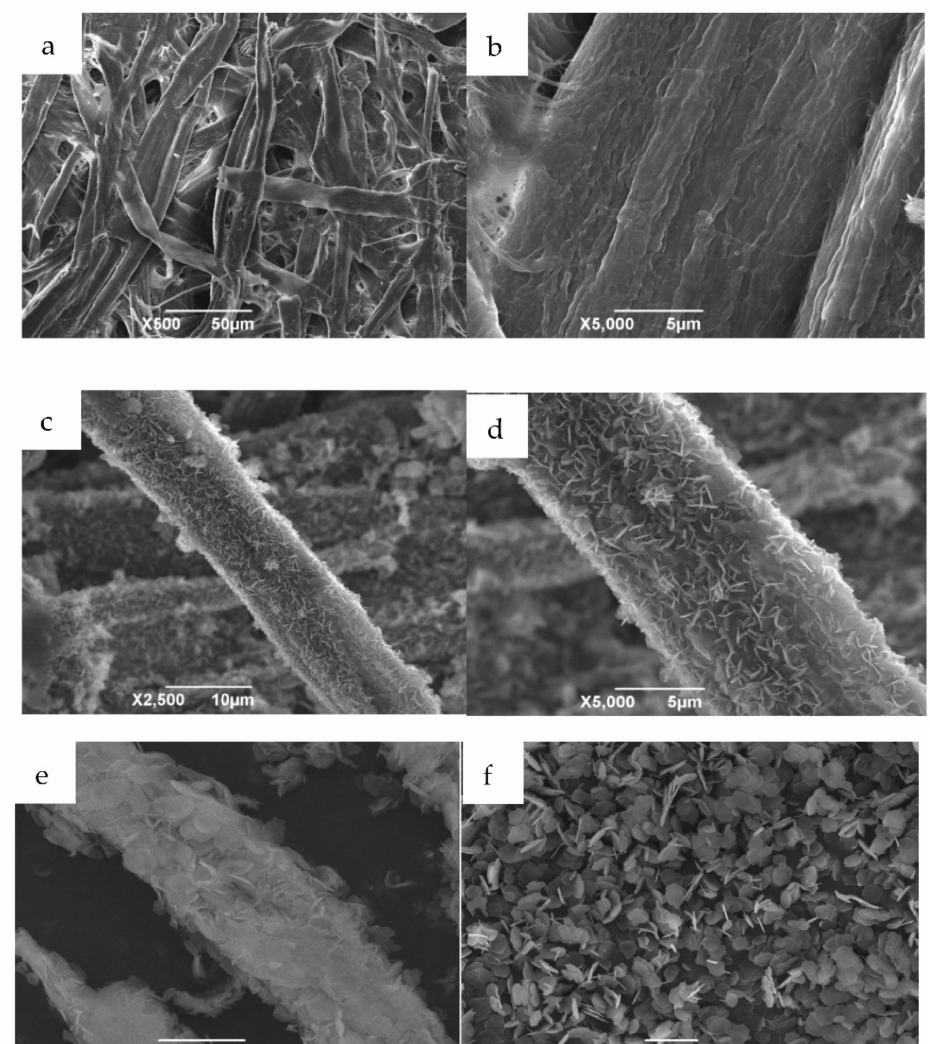
Figure 2. SEM images of filter paper ( a , b ); filter paper-templated Mg-Al LDH ( c , d ); filter paper- templated MgAl metal oxides (600 ◦ C, 3 h) ( e ); Mg-Al metal oxides crystallized without a template ( f